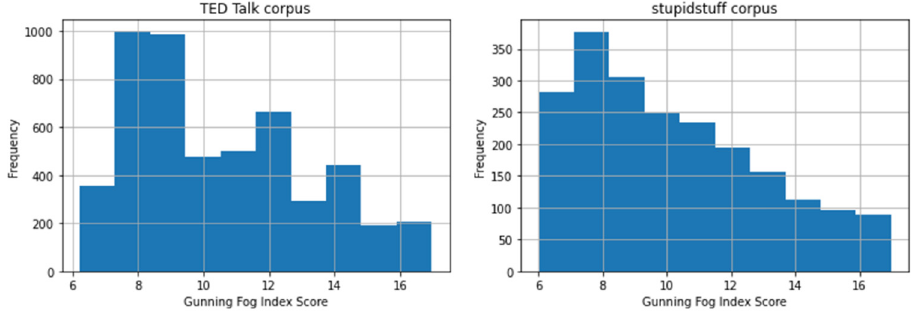
Figure 7. Histogram of readability scores for humorous sentences in TED Talks ( left ) and jokes from stupidstuff.org ( right ) using the Gunning Fog Index method. The score ranges from 6 (can be understood by sixth-grade students) to 17 (comprehensible to college graduate students).